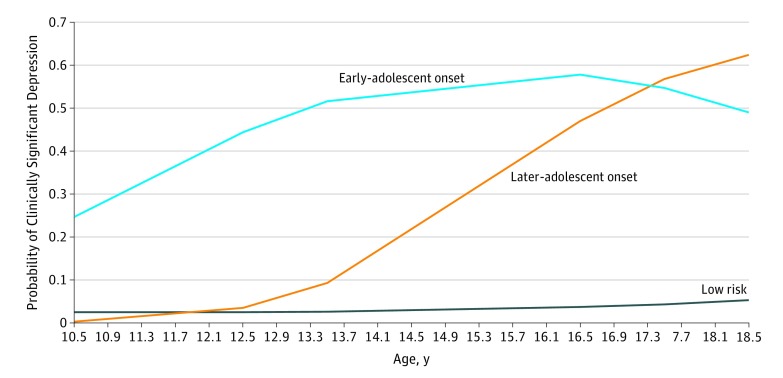
Developmental Trajectories of Depressive SymptomsDepression trajectories identified by latent class growth analyses.